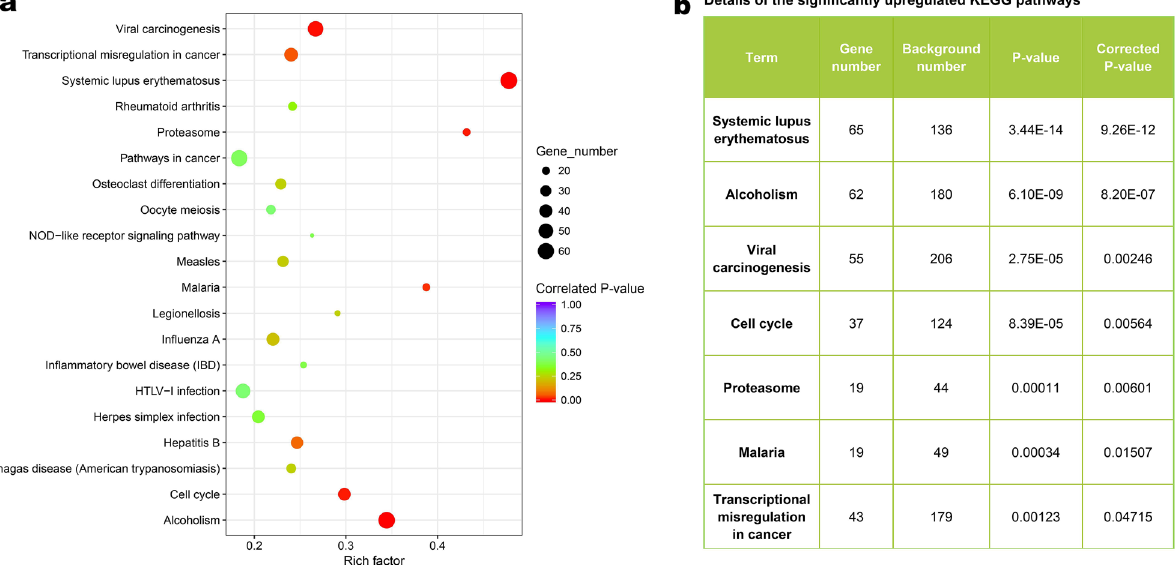
Figure 3. Kyoto encyclopedia of genes and genomes (KEGG) enrichment analysis. (a) Dot plot of pathway enrichment. The size of the dot represents the number of genes enriched in the pathway. The color of the dot represents the significance of the difference. (b) List of the significantly upregulated pathways in the systemic lupus erythematosus (SLE) group compared with the control (CTRL) group (corrected- P <